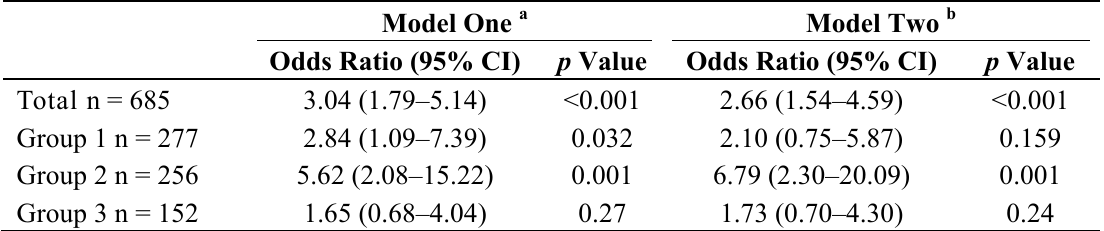
Table 2. Associations of MetS with CKD in multivariate logistic